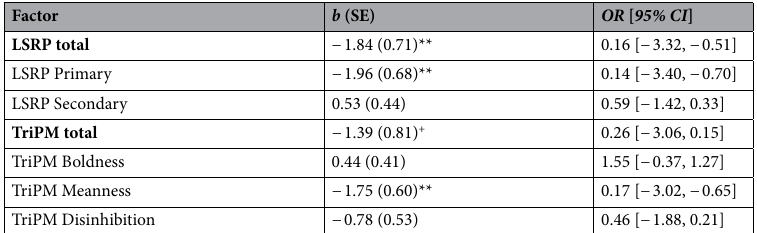
Table 2. Multiple logistic regressions predicting altruist status from psychopathy scores controlling for sociodemographic variables. Altruists were coded as ‘1’ and controls were coded as ‘0’. Beta values and standard errors are from multiple logistic regression models predicting altruist status from a single psychopathy sub- or total score while controlling for age, gender, and education. + P < .1; * P < .05; ** P < .01; *** P <